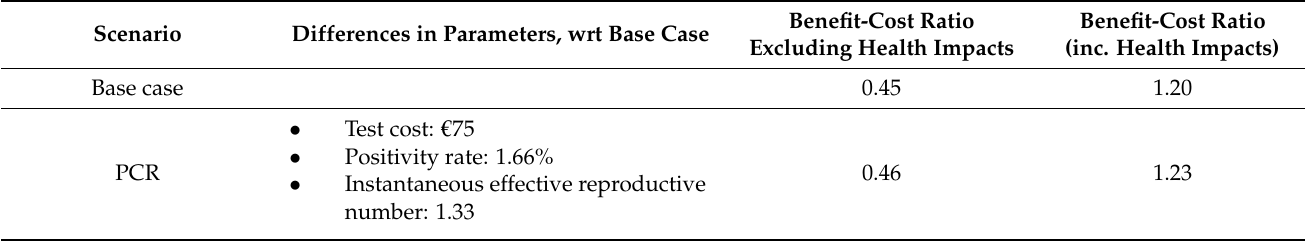
Table 4. Summary of results and sensitivity analysis of the cost effectiveness of a TTQ strategy, broken down by test type and wave of